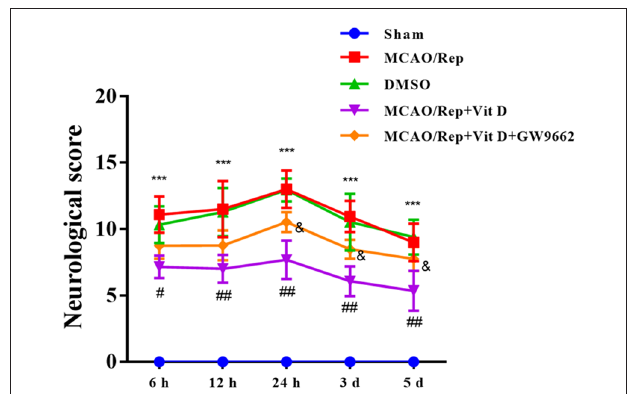
FIGURE 1 | Pre-treatment with 1, 25-D 3 (Vit D) improved MCAO/R-induced neurological impairment. The modified Neurological Severity Scale (mNSS) scores in the different groups were evaluated at 6 h, 12 h, 24 h, 3 days and 5 days after reperfusion. Data are represented as Mean ± SEM, n = 6, ∗∗∗ P < 0.001 vs. sham group, ## P < 0.01 vs. DMSO group, # P < 0.05 vs. DMSO group, & P < 0.05 vs. 1, 25-D 3 group. MCAO/R, middle cerebral artery occlusion/reperfusion; DMSO, dimethyl sulfoxide; PPAR- γ , peroxisome